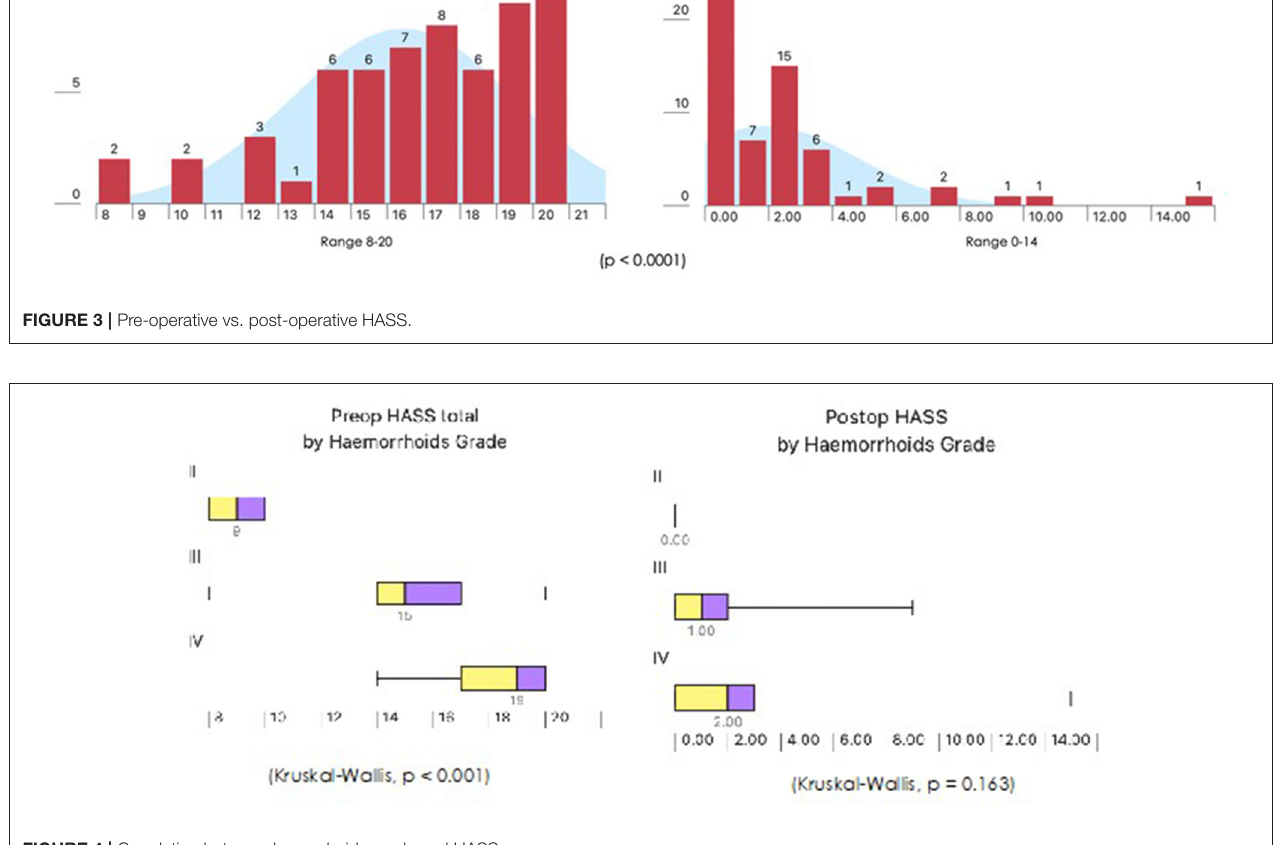
severity of the prolapse. For worse prolapse, the maximum length of the THD Slide TM device should be utilized. Regardless of the type of mucopexy performed, once the suture has been placed